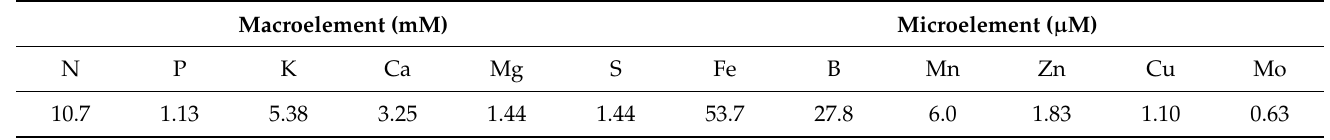
Table 1. Mineral composition of the full-strength, custom nutrient solution used for the experiment.